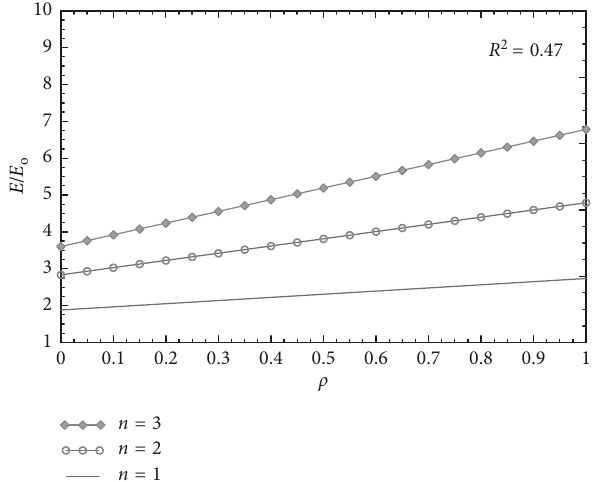
Figure 9: μ / μ - ρ curves of columns confined by the FRP system ε ε o for n � 1, n � 2, and n � 3.